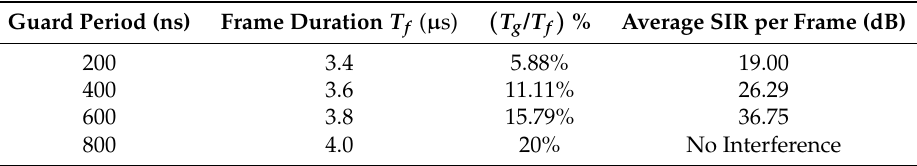
Table 3. Average signal-to-interference ratio Vs. the guard period.